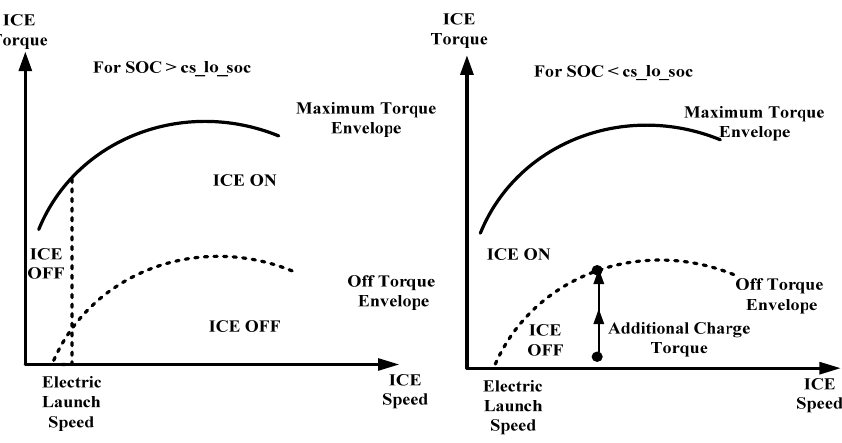
Figure 3. Energy management scheme.